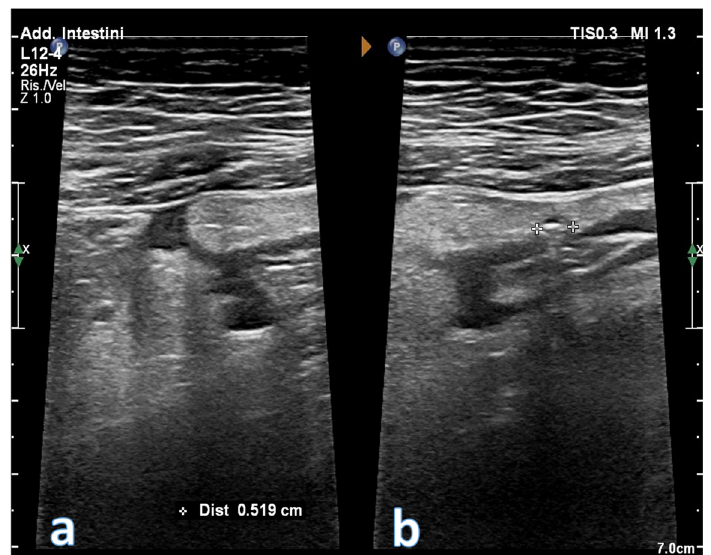
Figure 10. Images obtained with a high frequency linear probe. Sigmoid tract with thickened walls and evidence of a diverticular formation of the wall with an aerial artifact inside it ( b ). The peri ‐ sigmoid adipose tissue is thickened and hyperechoic. In image ( a ) an anechoic area is also visible which from the sigmoid wall moves towards the surrounding adipose tissue, suggestive for abscess area.